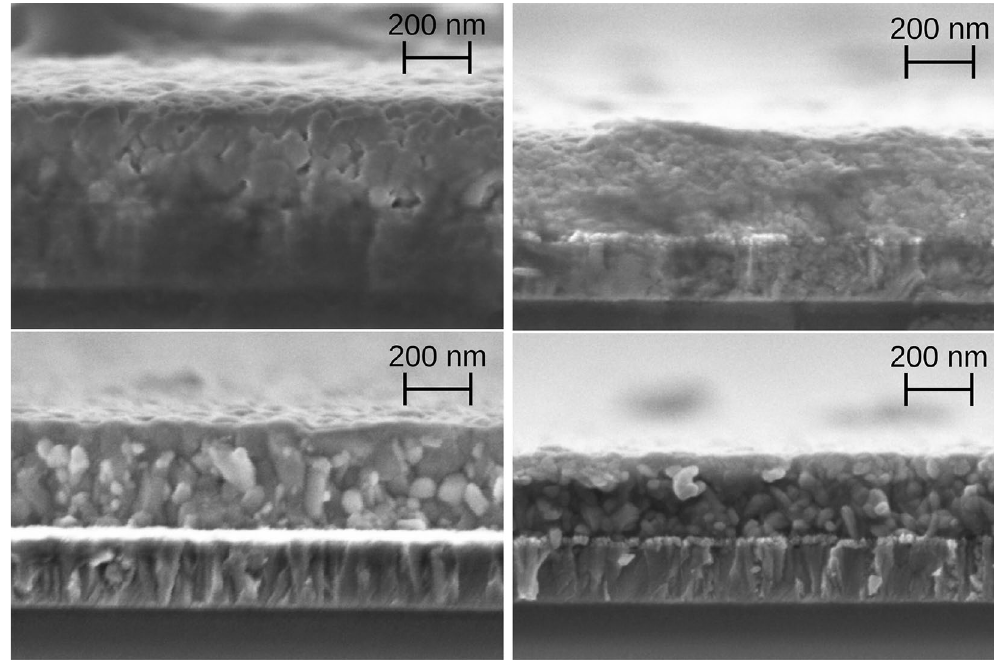
Figure 4. Cross-sectional SEM images of the perovskite absorbers of Eva 1 (top left), Eva 2 (top right), Eva 3 (bottom left) and Eva 4 (bottom right). The magnification was fixed at 80000.